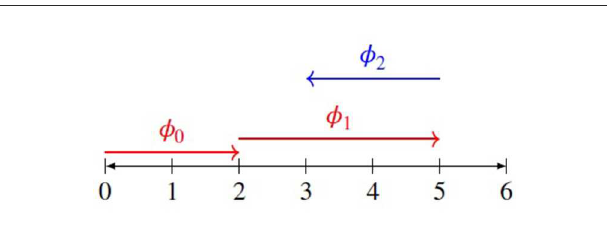
FIGURE1 A simplified version of the visualization of SHAP from Lundberg and Lee (2017). Each feature can be assigned a value, φ n , an additive sequence toward the prediction of a model. Here, we assume that the model starts with an expectation value of 2 (caused by φ 0 ), then “moves” to a score of 5 (caused by φ 1 ) and finally “lands on” a score of 3 (caused by φ 2 ). These shifts are not actually present in the model, but in SHAP’s explanation of the